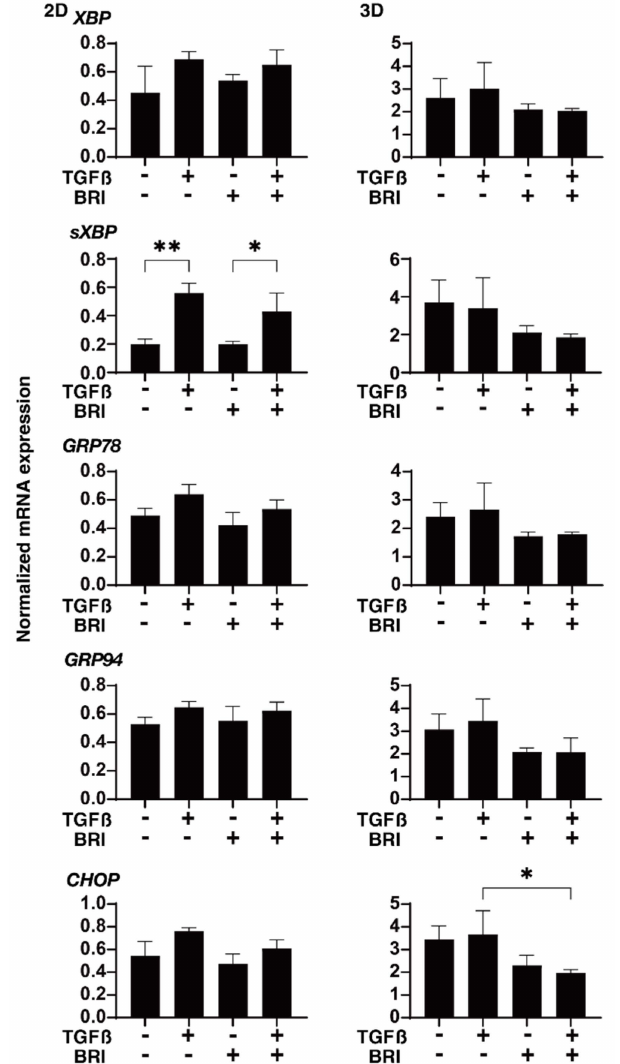
Figure 8. Effects of brimonidine (BRI) on the gene expression of major ER stress-related genes in TGF- β 2-treated 2D and 3D HTM cells. The 2D- and 3D-cultured HTM on day 6 were untreated (NT) or treated with 5 ng/mL TGF- β 2 (TGF β ) in the presence or absence of 10 µ M brimonidine (BRI) and were applied to qPCR analysis to evaluate the gene expression of major ER stress-related genes, including the XBP1, spliced XBP1 (sXBP1) GRP78, GRP94, and CHOP. All experiments were conducted in triplicate using freshly prepared samples (2D cells; n = 5 and 3D spheroids; n = 15–20) in each experimental condition. “+” is reagents addition. “ − ” is reagents non-addition. Regarding the data, the mean ± standard error of the mean (SEM) are shown. * p < 0.05, ** p < 0.01;